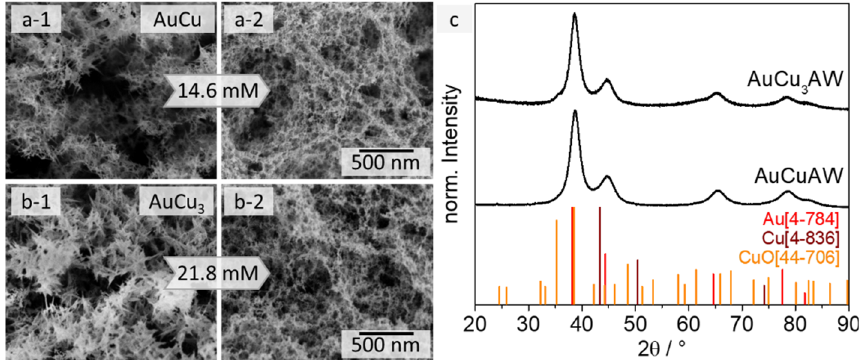
Figure 3. SEM images of AuCu ( a ) and AuCu 3 ( b ) gels before ( 1 ) and after ( 2 ) the acid treatment with HCOOH. The gel networks are covered with CuO needles before the acid washing, which disappear after the HCOOH treatment and the sponge-like gel structure remains. XRD measurements ( c ) prove the successful removal of the CuO side phase.